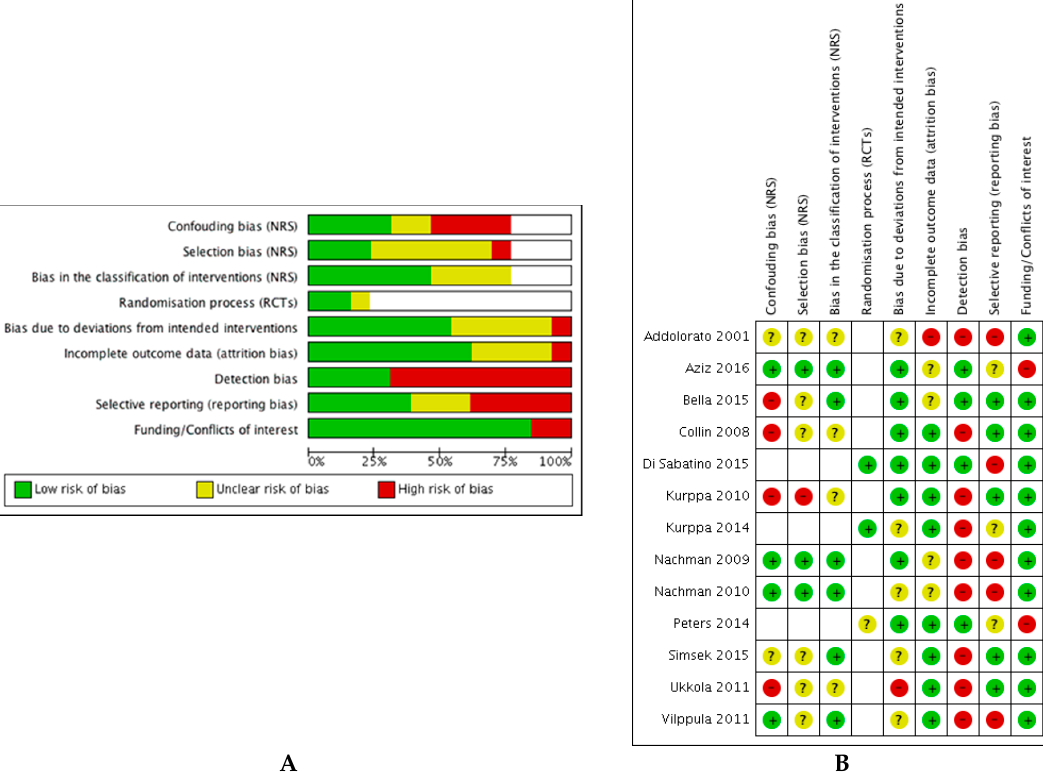
Figure 2. ( A ) Risk of bias graph: Review authors’ judgements about each risk of bias item presented as percentages across all included studies. ( B ) Risk of bias summary: Review authors’ judgements about each risk of bias item for each included study.